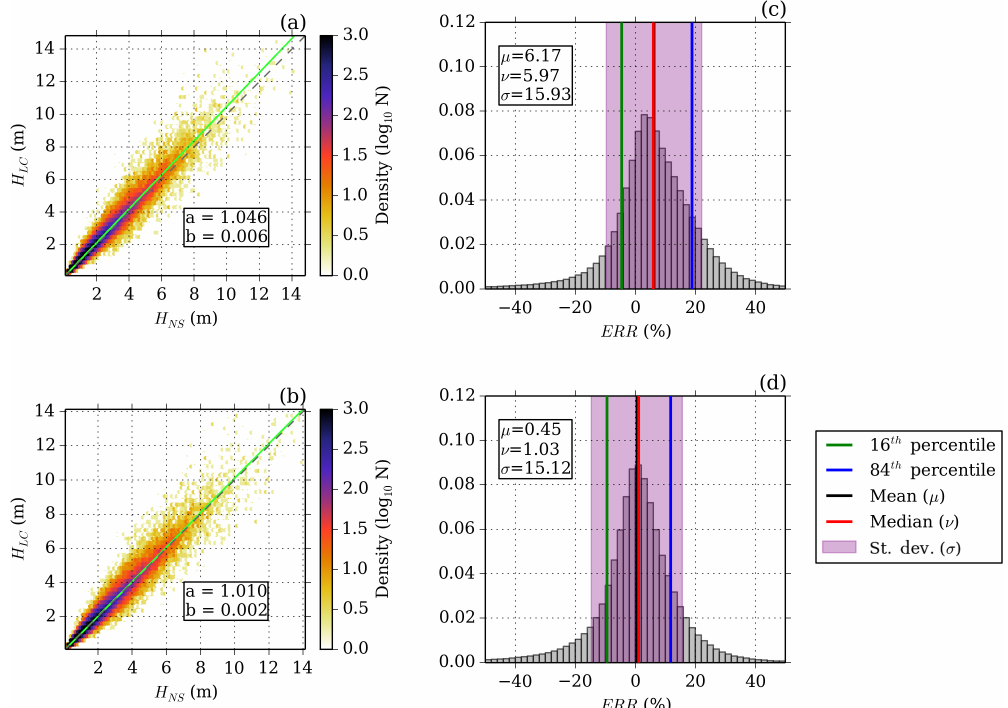
Figure 4. Validation results. Misfit between the considered LC and NS waveforms using (top) the latitude and coastal crop (lat/crop) correc- tion, (bottom) lat/crop correction and potential energy preservation, for all magnitudes and mechanisms. (a, b) Scatter plots between LC and NS tsunami maxima and (c, d) LC percentage error with respect to NS for different method